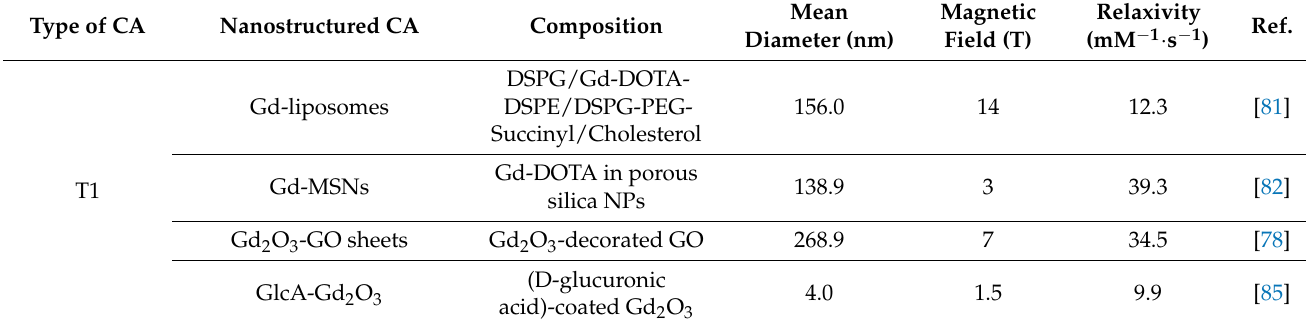
Table 1. Size, magnetic field, and relaxivity values of potential nanostructured contrast